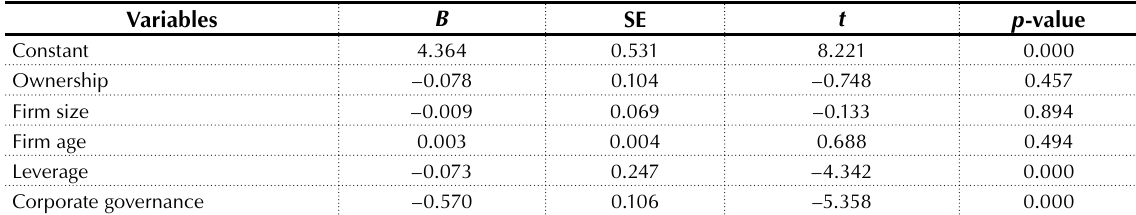
Table 6. Ordinary least squares regression analysis of shareholder activism score versus corporate governance